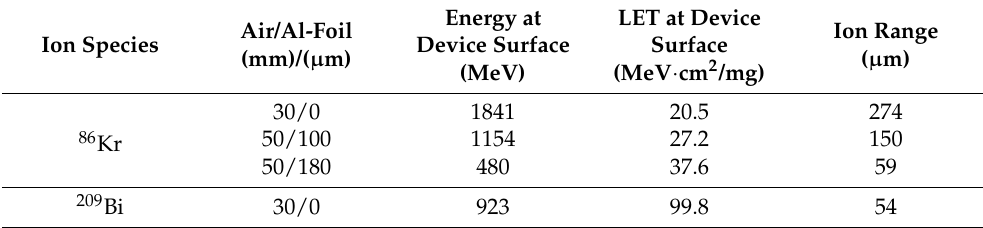
Table 1. Ion spices, energy, LET, and range in silicon.